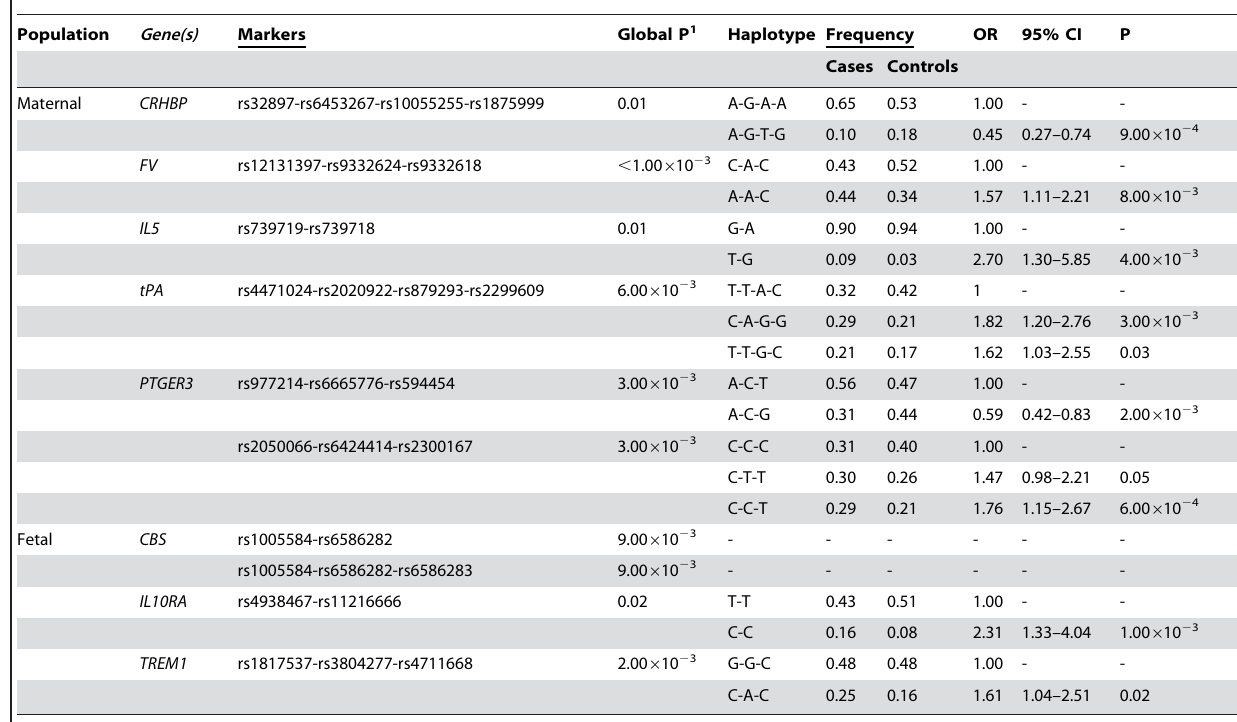
Table 7 . Haplotype frequencies and OR for strongest sliding window